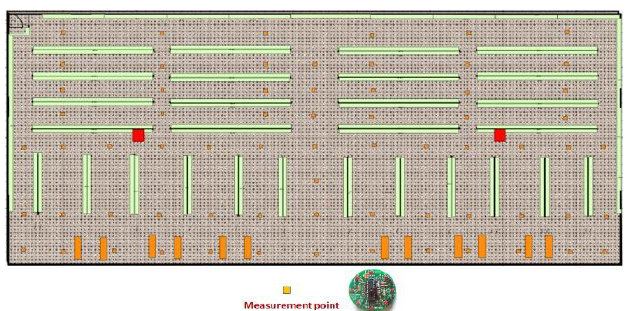
Figure 112. Map of measurement points of the sensor network